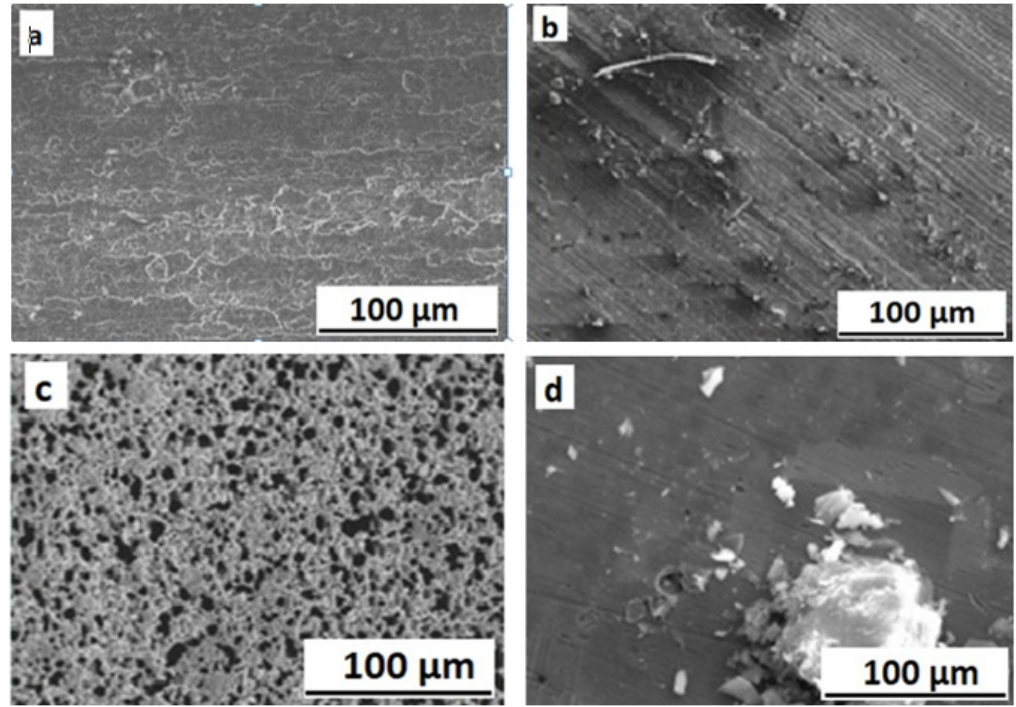
Figure 6. Surface morphology of 304 stainless steel after corrosion in ( a ) untreated 304 SS, ( b ) 3.5 % NaCl + CO 2 environment, ( c ) 3.5 % NaCl + CO 2 + H 2 S environment, ( d ) 3.5% NaCl solution.